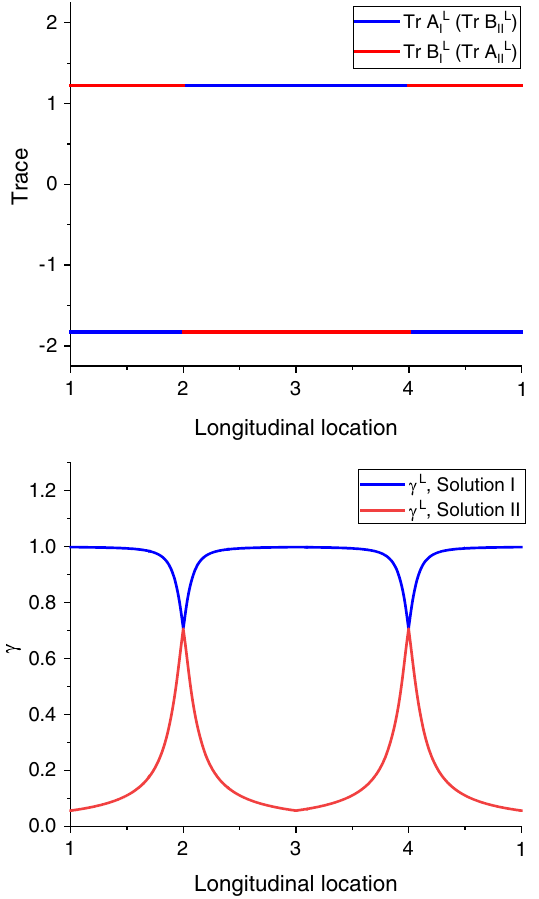
FIG. 2. Traces of A L and B L matrices (top) and the parameter γ L (bottom) of the large ring one-turn map. It is noted that Tr A of solution I(II) is equal to Tr B of solution II(I). The betatron tunes of the original ring are varied in a range of Q x ¼ 0 . 3 ∓ 0 . 005 and Q ¼ 0 . 3 (cid:1) 0 . 005 . The resonance condition, Q y filled at locations 2 and 4. The beta functions of the original rings are set to arbitrary values ( β x ¼ 10 m, β y ¼ 5 m) and constant. The integrated, normalized skew quadrupole strength is set to 0 . 001 m − 1 , corresponding to j C j ∼ 0 . 001 . The large ring consists of 400 000 þ 1 original rings, ensuring smooth connections of one-turn maps and avoiding an integer